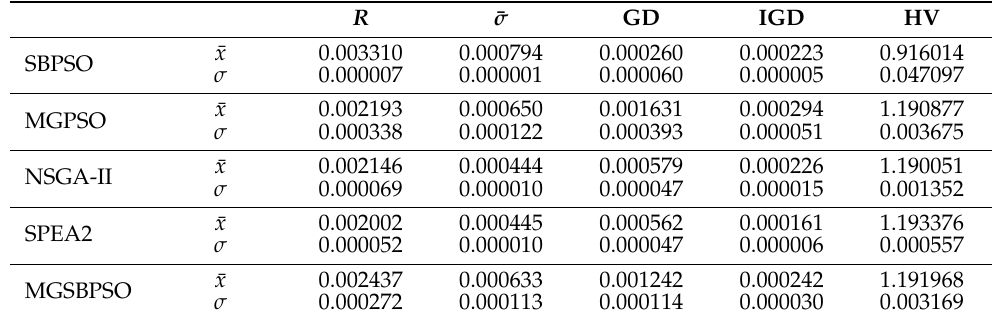
Table 13. Nikkei 225 results for each performance